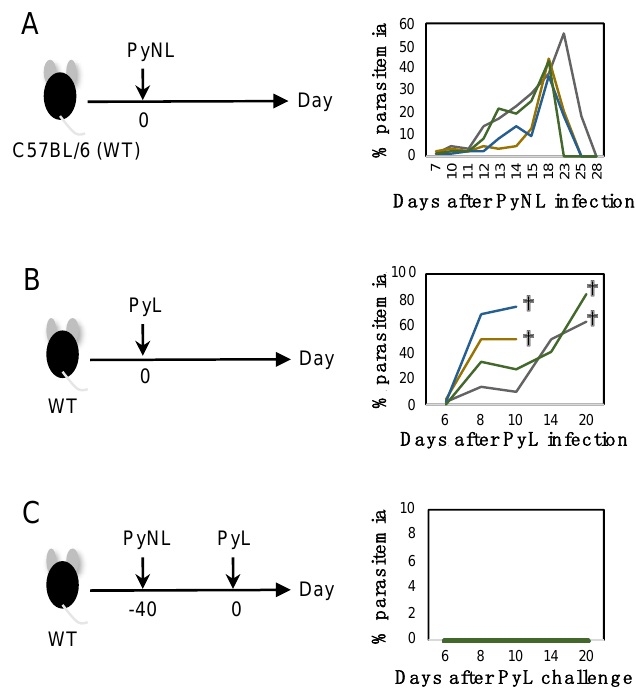
Figure 1. Plasmodium yoelii 17XNL (PyNL) infection as a naturally attenuated blood-stage parasite vaccine. Each line indicates parasitemia of one mouse. ( A ) Study protocol of blood-stage PyNL infection (left panel) and changes of parasitemia of PyNL infected mice (right panel). Parasitized red blood cells (RBCs) (50,000 pRBCs) were inoculated i.p. into C57BL / 6 mice on day 0. Typically, all mice controlled the infection within 1 month. N = 4. ( B ) Blood-stage PyL (lethal) infection. N = 4. ( C ) PyNL recovered mice were challenged with Plasmodium yoelii 17XL (PyL). N = 4. Table 1. Cross-strain protection by PyNL infection followed by PyL challenge in immunodeficient mice. Mouse N (7–60)